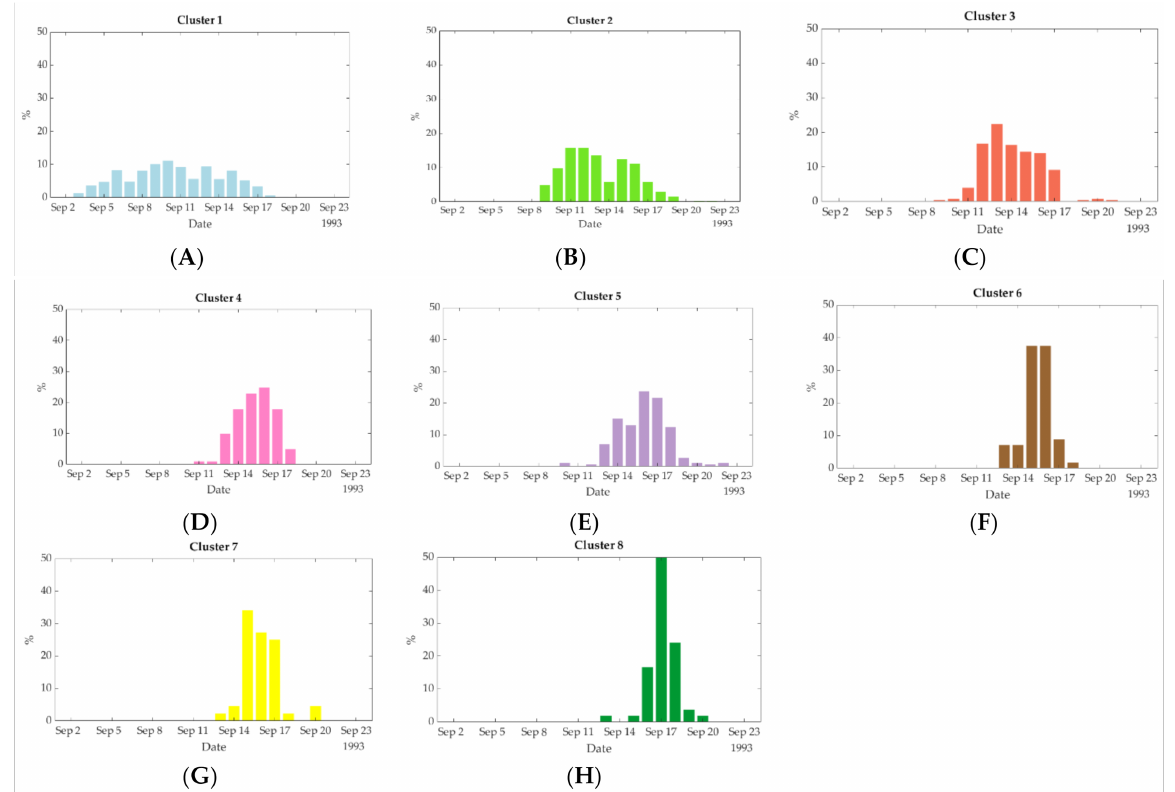
Figure 10. Daily rate of growth of each cluster in relation to the maximum number of events in a given cluster. ( A ) cluster 1, ( B ) cluster 2, ( C ) cluster 3, ( D ) cluster 4, ( E ) cluster 5, ( F ) cluster 6, ( G ) cluster 7, ( H ) cluster